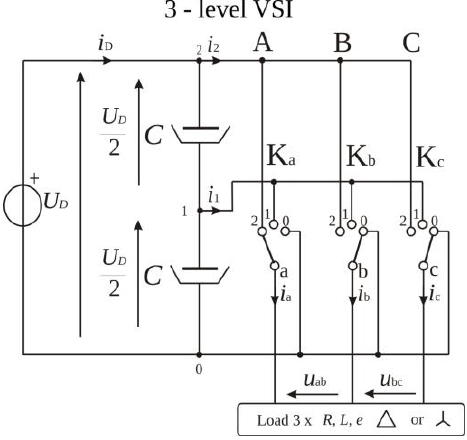
Figure 4. The model of the three-level inverter with three switches.